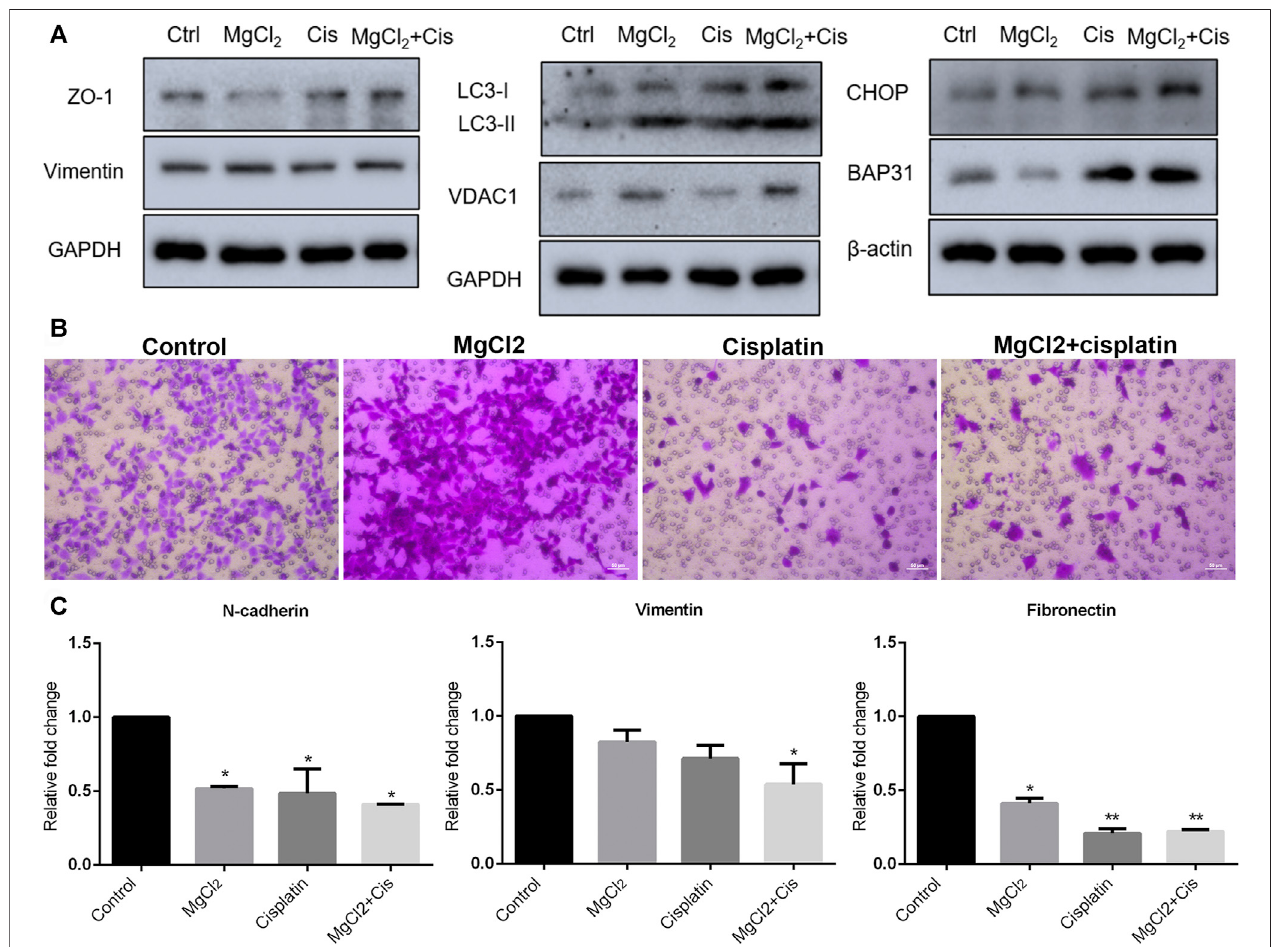
FIGURE 3 | Migration of UC3 bladder cancer cells that received combinatorial treatment with MgCl 2 and cisplatin (Cis). (A) Protein expression of migration-related genesasdetermined bywesternblotanalysis.Densitometryofwesternblotwasshowedin SupplementaryFigureS7A . (B) Cellmigrationwasevaluatedbythetrans- well assay after cells treatment with MgCl 2 and/or cisplatin for 24 h (also seen Supplementary Figure S7B ). (C) mRNA expression of migration-related genes as examined by qPCR (mean ± SEM of duplicate experiments). * p < 0.05 vs. control and ** p < 0.01 versus control.